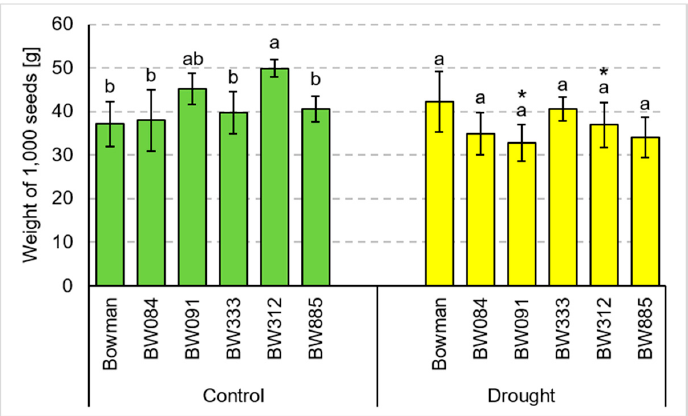
Figure 6. Weight of 1000 seeds of the analyzed genotypes under the optimal watering (control) conditions and after the drought stress (the pot experiment). The mean values ± (SD) marked with the same letters (separately for the control and drought-stressed plants) are not significantly different, according to Duncan’s test ( p ≤ 0.05). Asterisks denote significant difference in comparison of values reported in each genotype between the control and drought conditions according to Student’s t -test. Details are given in the text.